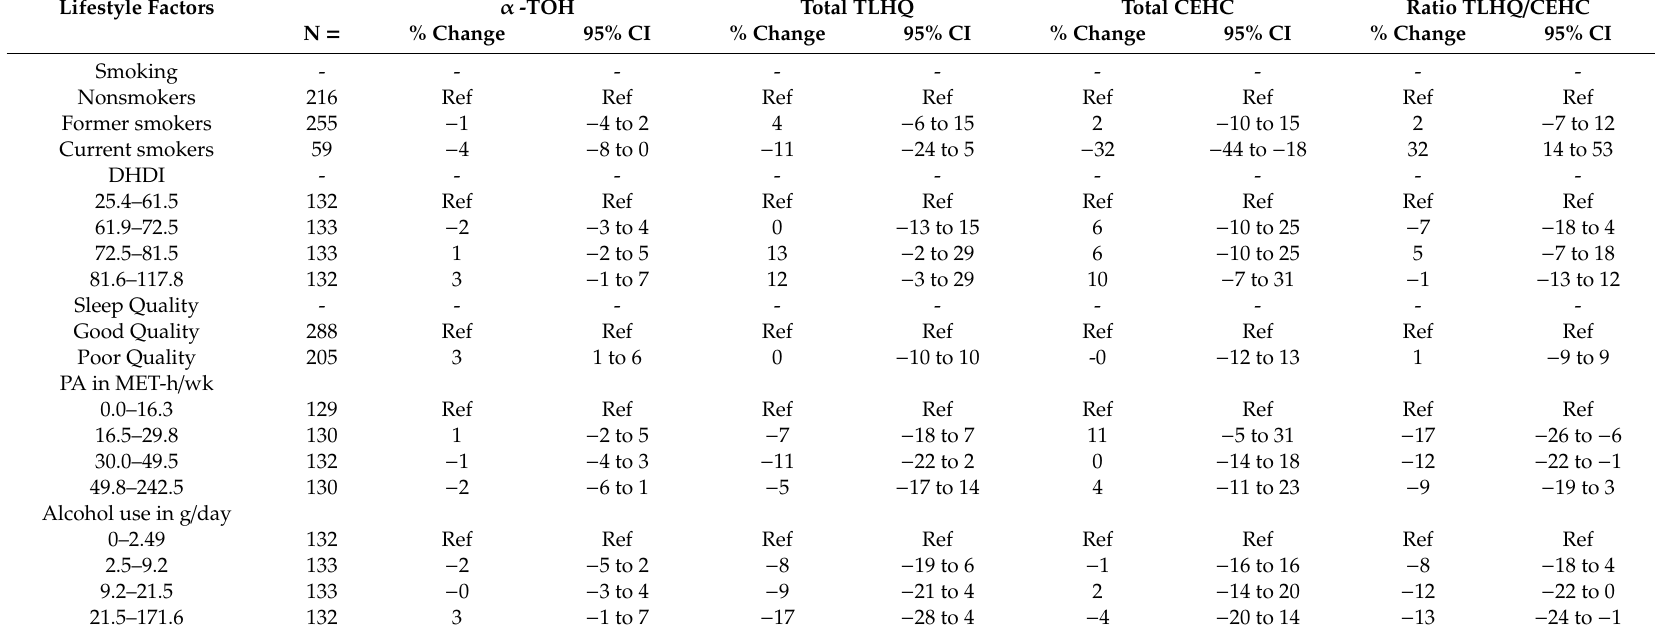
Table 2. Associations between lifestyle factors and di ff erent measurements of vitamin E